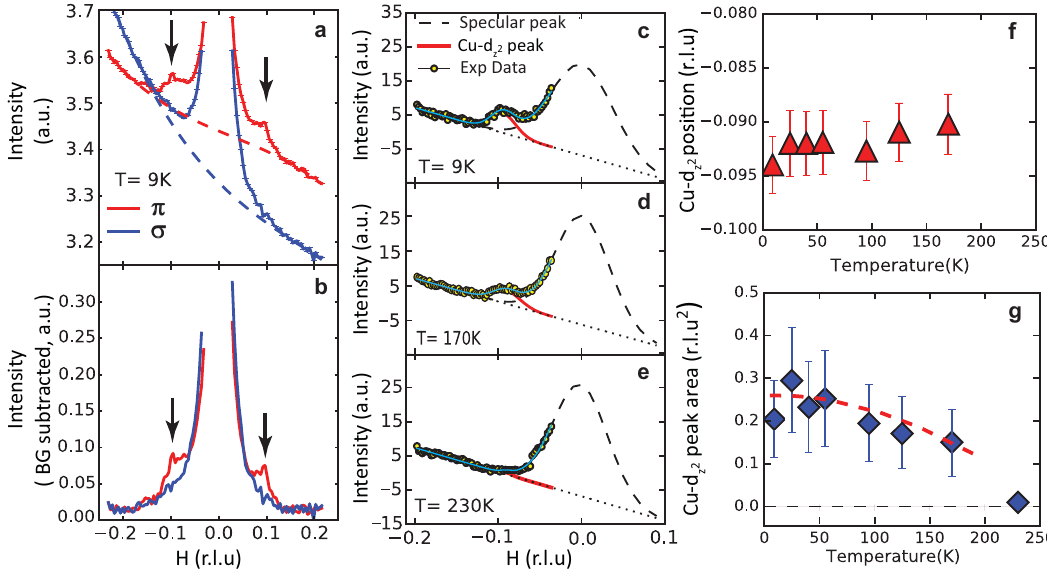
Fig. 3 Summary of a REXS study of the charge order peaks in a NYN trilayer with x = 0.5, y = 0.25. a Wide-range H -scan at 9 K which con fi rms that the Bragg peak due to the Cu d z 2 order is seen on both sides of the specular peak. b Background subtracted scans showing the strong polarization dependence of the Bragg peaks due to the Cu d z 2 order that are marked by black arrows. c – e Partial scans of the Bragg peak around ( − 0.096, 0, and 1.56) for selected temperatures of 9, 170, and 230 K, respectively. For each temperature, the plotted experimental data (open circles) represent the average of several consecutively acquired scans. The solid cyan lines denote the total fi t. The background (described with a linear function) is shown as dotted line and the specular peak (Gaussian function) with a dashed line. The obtained Bragg peak of the Cu d z 2 order is displayed by a solid red line. Graphs ( f ) and ( g ), respectively, display the obtained temperature dependence of position and area of the Bragg peak of the Cu- d z 2 order. In graph ( g ), the dashed red line is a guide to the eye. The propagation of uncertainty in peak position and area were calculated from the results of the fi tting using standard procedures 39